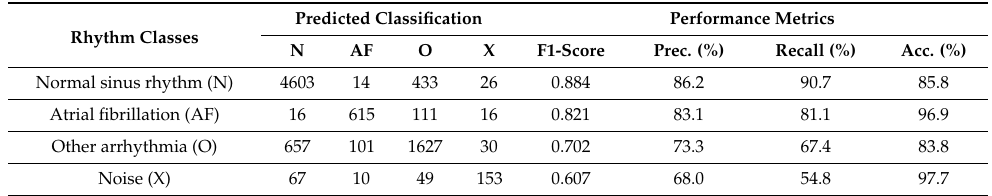
Table 3. Average confusion matrix and performance of the optimized DenseNet-3@128-32-4 model based on 5-fold cross-validation.